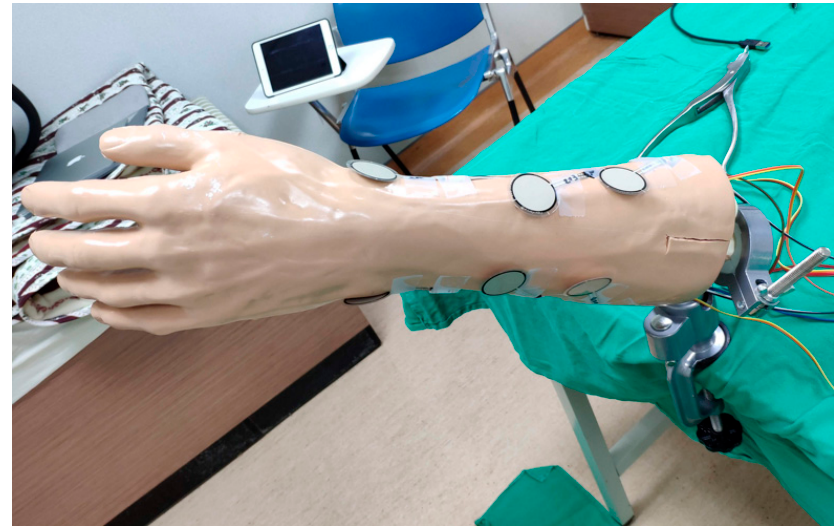
Figure 4. The simulated arm was fixed to a clamp which was mounted to a bench top.